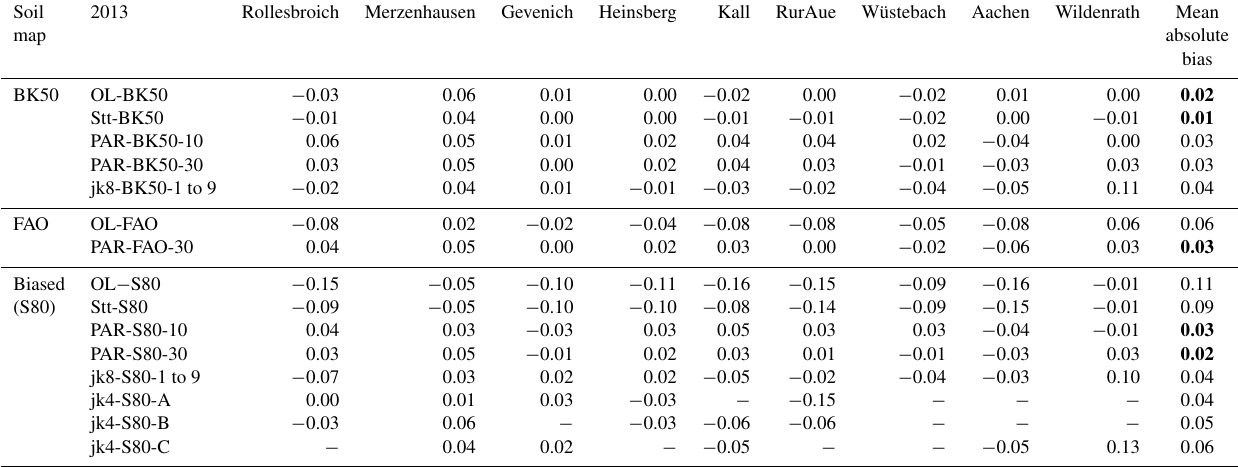
Table A4. Bias (cm 3 cm − 3 ) at CRNS sites for open loop, data assimilation and jackknife simulations compared to CRNS SWC retrievals for the data assimilation period (2011 and 2012). For jackknife experiments (21 in total) only the bias of the omitted sites is reported. The best cases are marked in